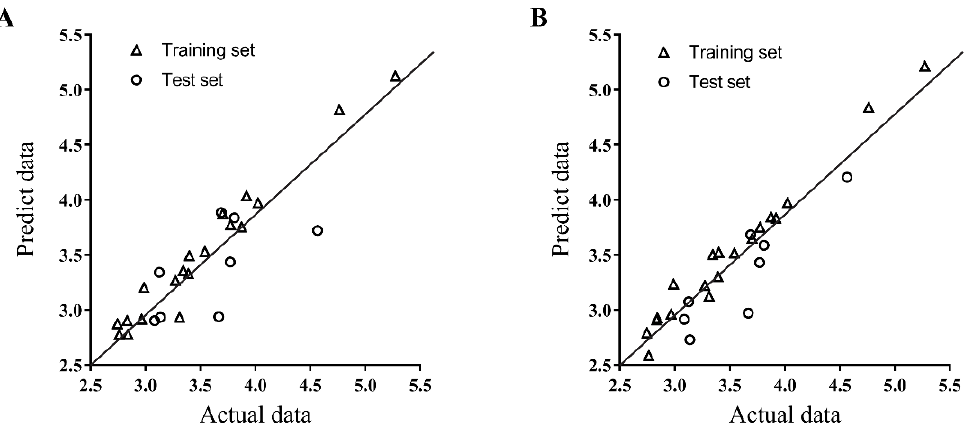
Figure 5. Plots of predicted inhibition values versus the actual values for the training set and the test set compounds from the CoMFA ( A ) and CoMSIA ( B ) models. The experimental and predicted data of CD4 competitive binding inhibition was presented as -ln. Table 4. Experimental and predicted CD4 competitive binding inhibition of compounds in training and test sets by